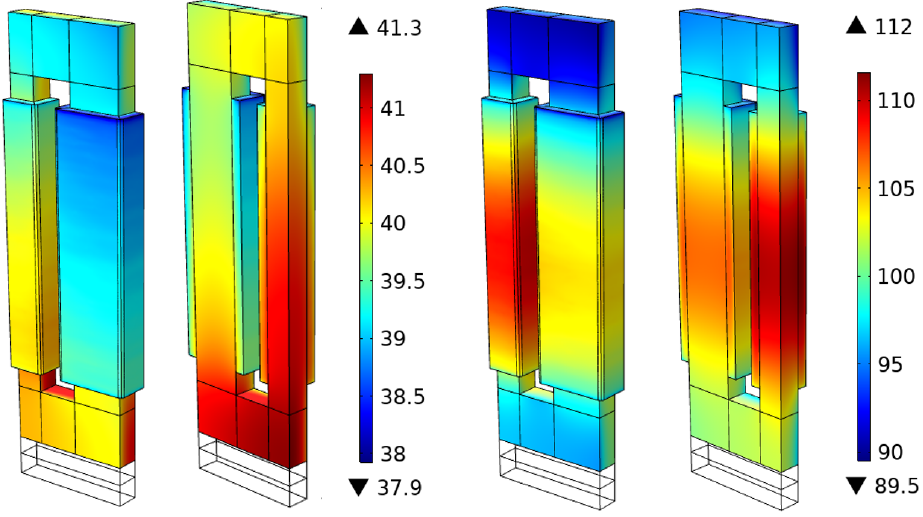
Figure 9. Snapshots of the simulated temperature distribution, in °C, of the transformer under steady-state conditions. Cases 1 ( left ) and 6 ( right ).